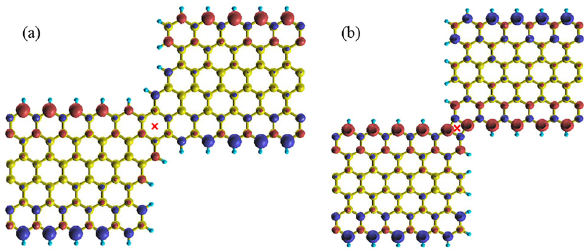
Figure 4: The real space distribution of spin density of: (a) Junction C6; (b) Junction C4. The red cross indicates the spatial inversion center of the device. It is clearly seen that the spin density in Junction C6 is anti-symmetrical with respect to the spatial inversion center while it is symmetrical in Junction C4.